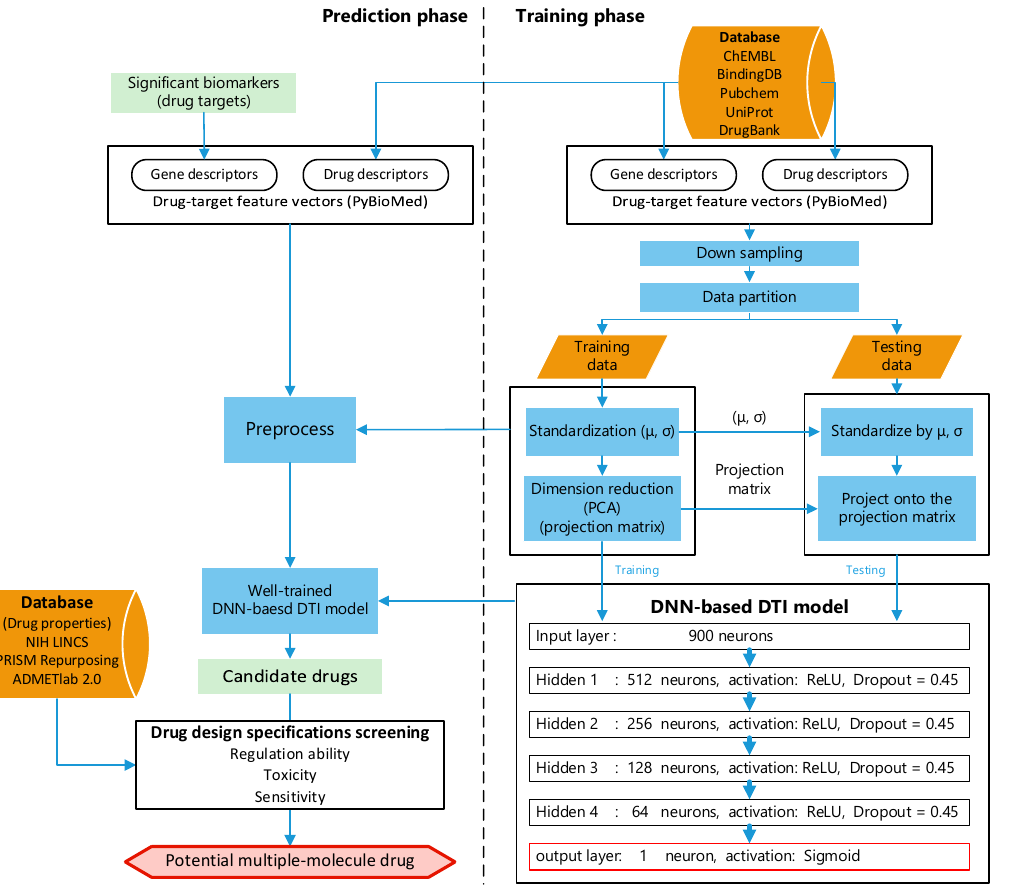
Figure 4. The flowchart of multiple-molecule drug design of the amplification and saturation stages of SARS-CoV-2 infection based on DNN-based DTI model and drug design specifications. The DNN-based DTI model was first trained by DTI data at the right column. Then, the well-trained DNN-based DTI model was used for the prediction of candidate drugs and the candidate drugs were finally screened by drug design specifications as the potential drugs to combine a multiple-molecule drug in the left column.